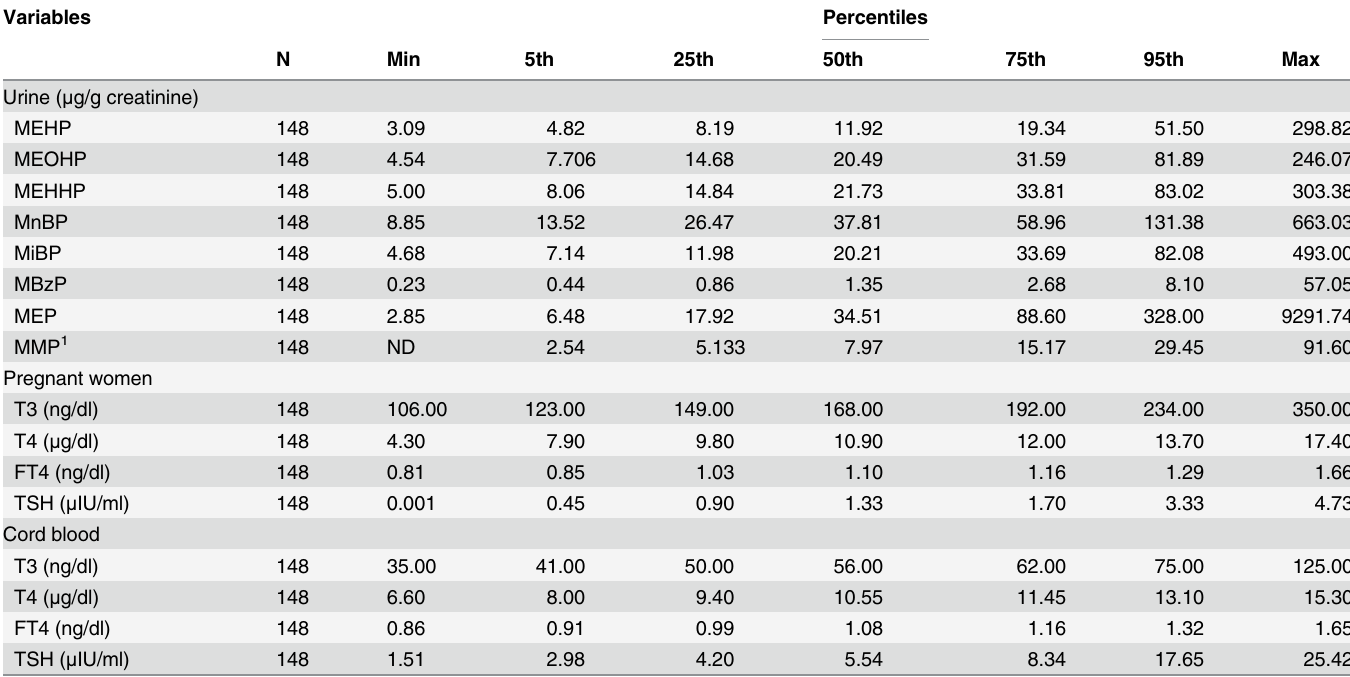
Table 2. Distribution of urinary phthalate metabolites and serum thyroid profiles in pregnant women and their cord blood serums.